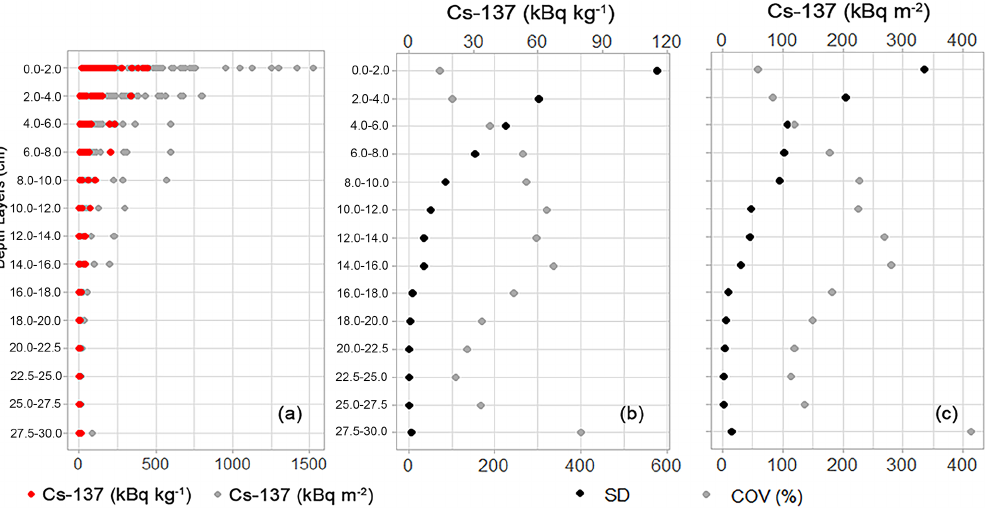
Figure 5. (a) Depth distributions of Cs-137 concentrations in kBqkg − 1 (red) and kBqm − 2 (gray). Standard deviations (red) and COVs (gray) by depths in (b) kBqkg − 1 and (c) kBqm − 2